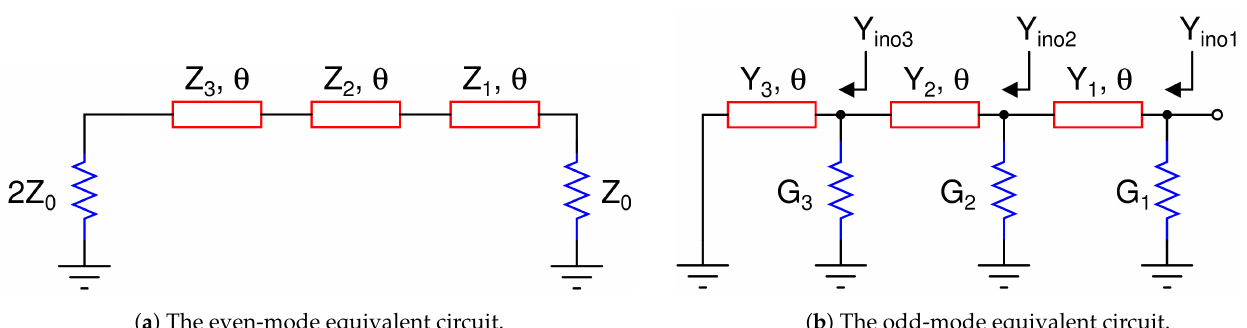
Figure 3. The even- and odd-mode equivalent circuits of the three-section